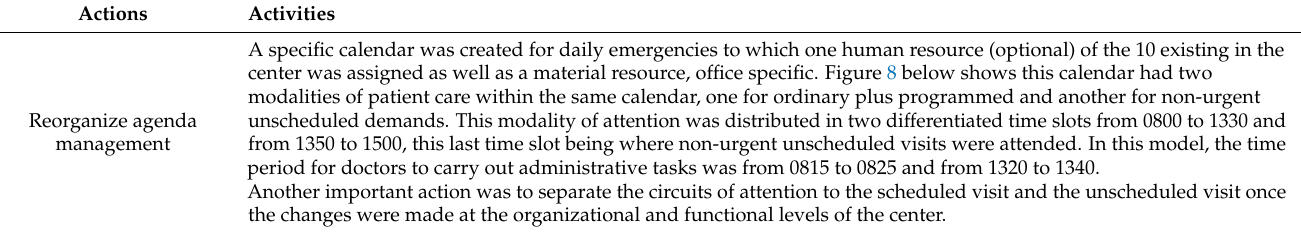
Table 5. Action plan and